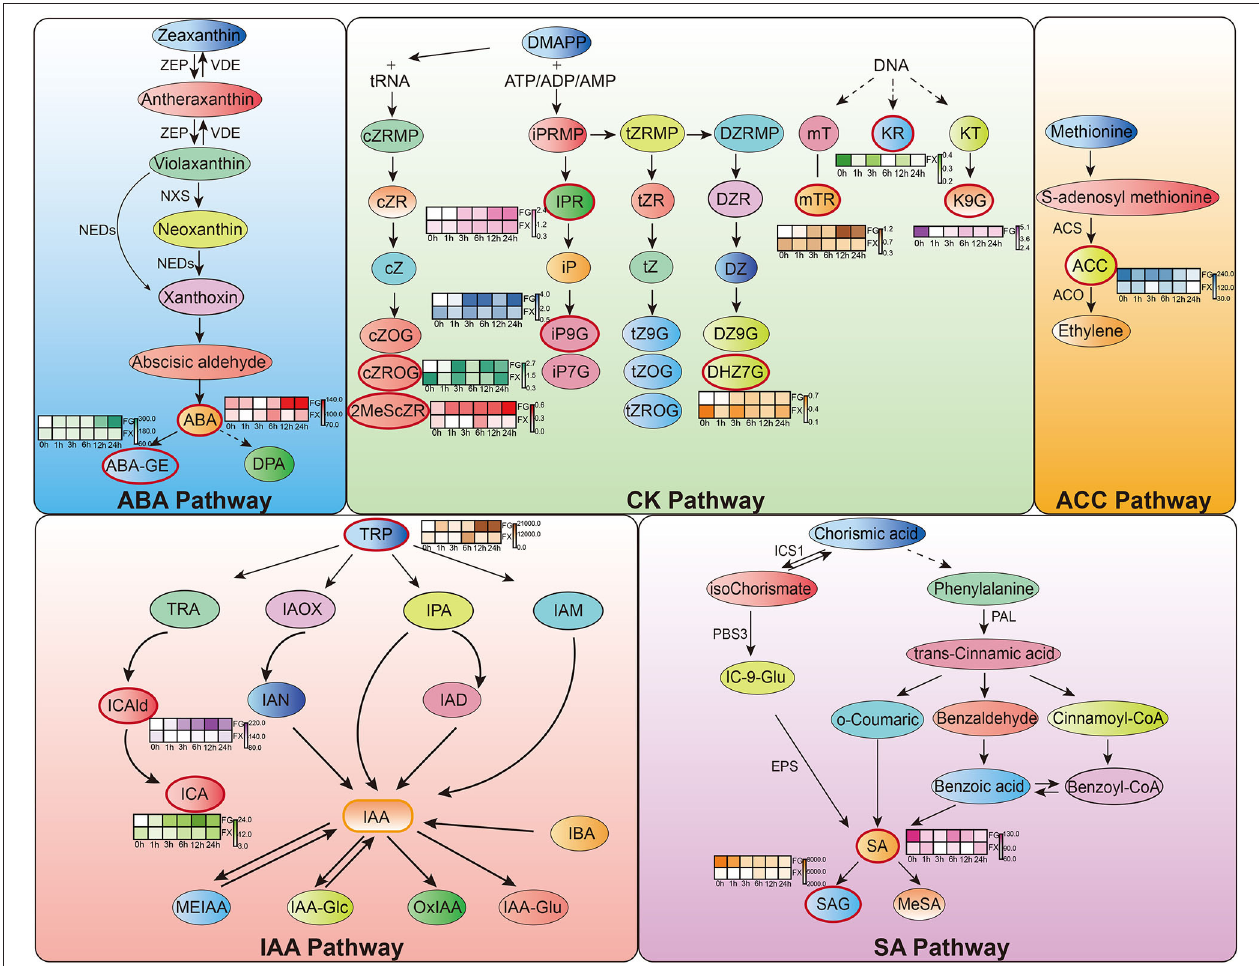
FIGURE 6 | Hormone response pathways in Z. bungeanum under cold stress. Red boxes indicate important hormone components identified from orthogonal partial least squares discriminant analysis (OPLS-DA). The heat map graph beside them shows the content change pattern of each important hormone